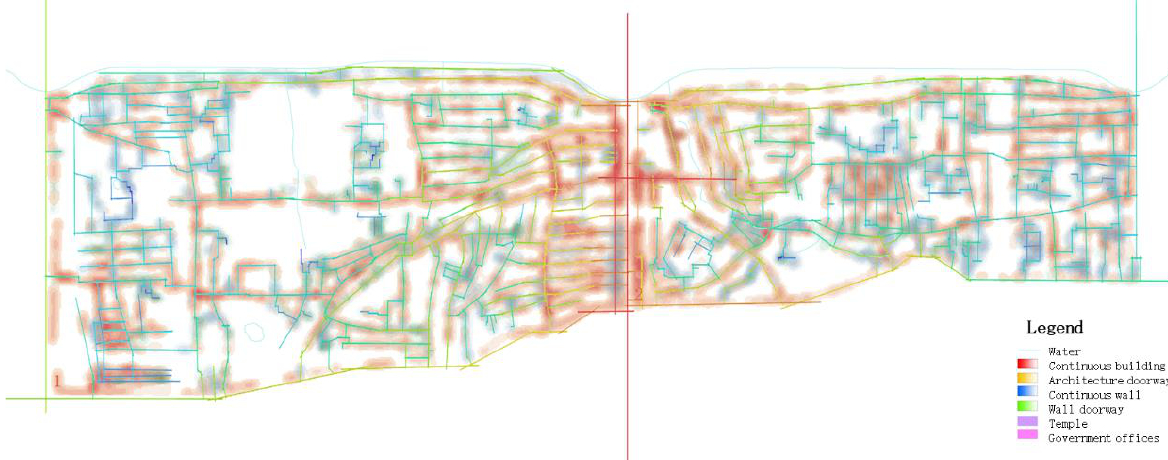
Figure 15. Building form kernel density superimposed street and lane integration